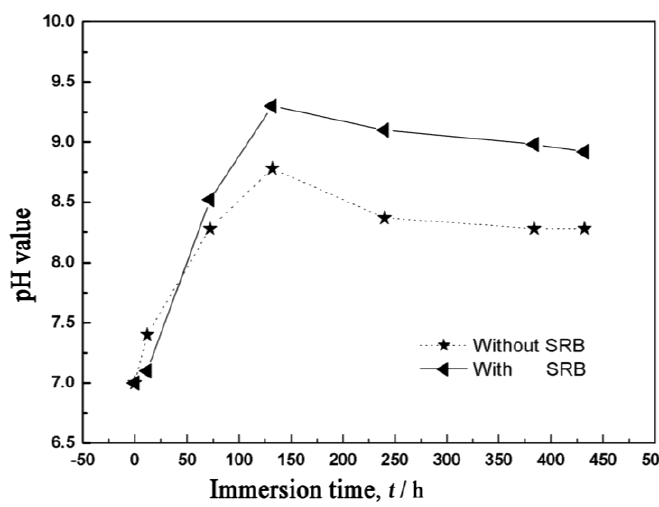
Figure 5. Variation of the pH value with